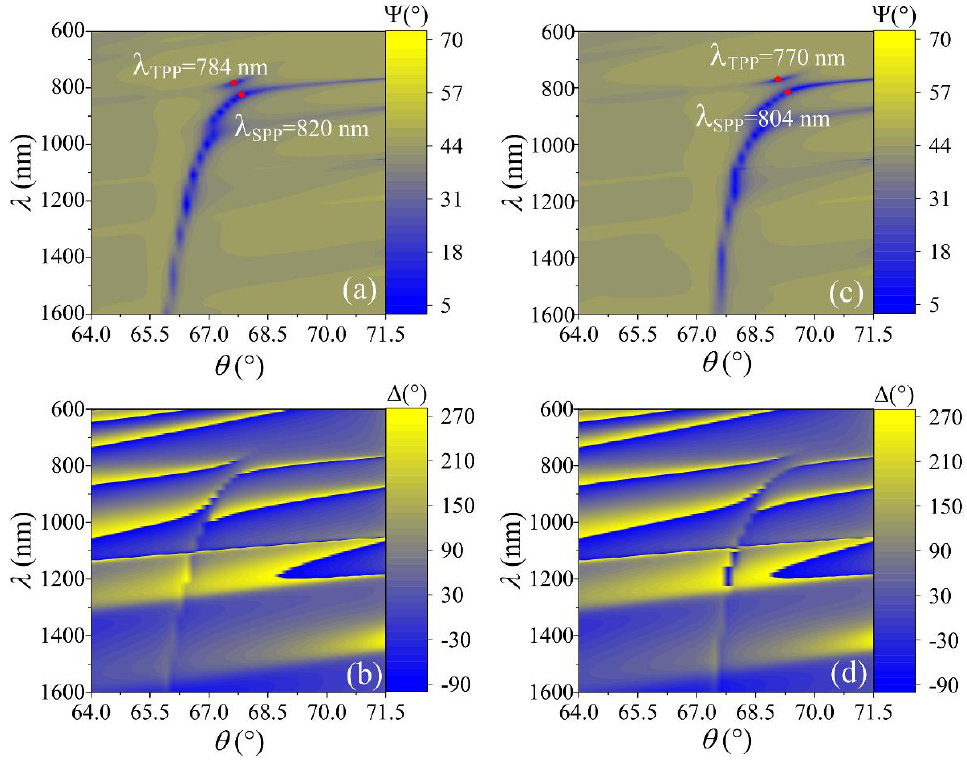
Figure 2. The dispersion maps λ (θ) of ellipsometric parameters Ψ(°) ( a , c ) and Δ(°) ( b , d ) for structure PC (TiO 2 /SiO 2 (110 nm/200 nm)/Au (50 nm) in water (left side) and in ethanol (right side). The red points show the strong coupling effect between the Tamm plasmons and the surface plasmon at zero detuning.